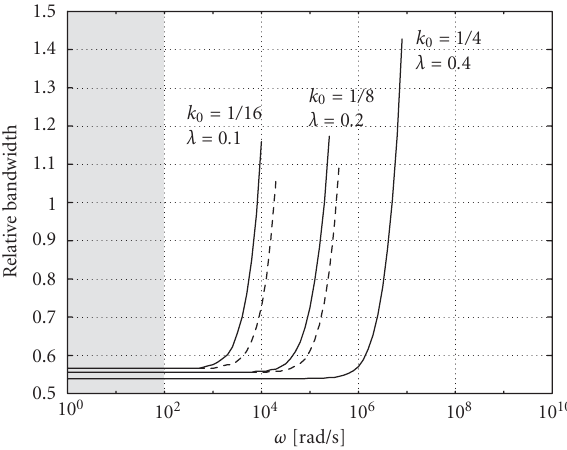
Figure 7: The overall equivalent lattice network relative spatial bandwidth as a function of the input stimulus temporal frequency, for the time constant characteristic of the interaction among cells τ 1 = 10 − 7 second. Solid and dashed curves describe the e ff ect of the ratio of the two time constants. The shaded region evidences the temporal bandwidth of perceptual